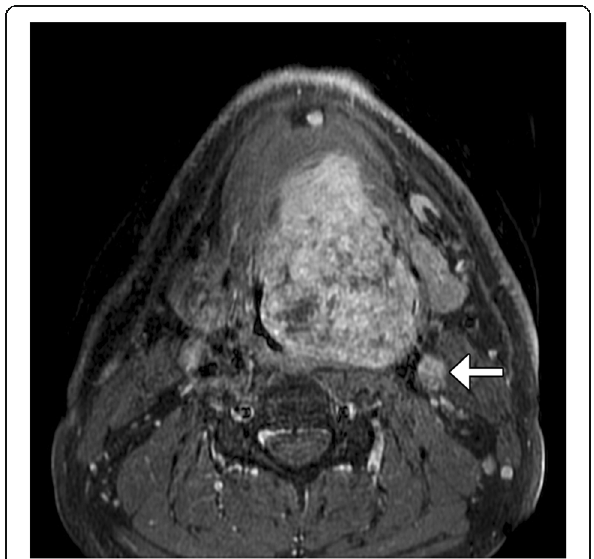
Fig. 2 Polymorphous adenocarcinoma (PAC). Axial fat-suppressed T2-weighted MRI shows a bulky heterogeneous mass involving the oral cavity and tongue base with associated left level 2 metastatic lymphadenopathy